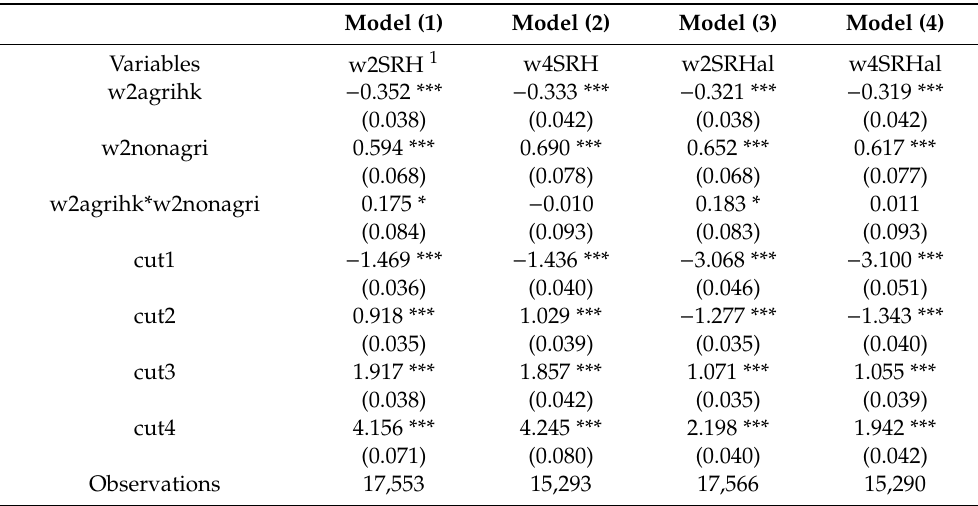
Table 13. Using the China Health and Retirement Longitudinal Survey (CHARLS) to employ a robustness check for the healthy migrant